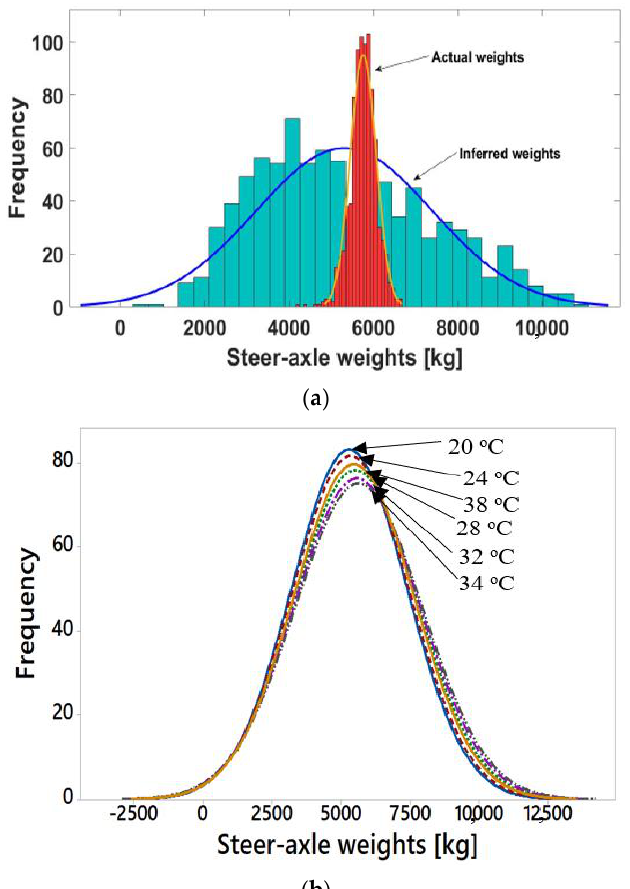
Figure 17. ( a ) Histograms of actual weights and the inferred steer-axle weights of trucks at 20 °C internal bridge temperature; ( b ) Normal distribution fits of inferred steer-axle weights with different mean internal temperatures.